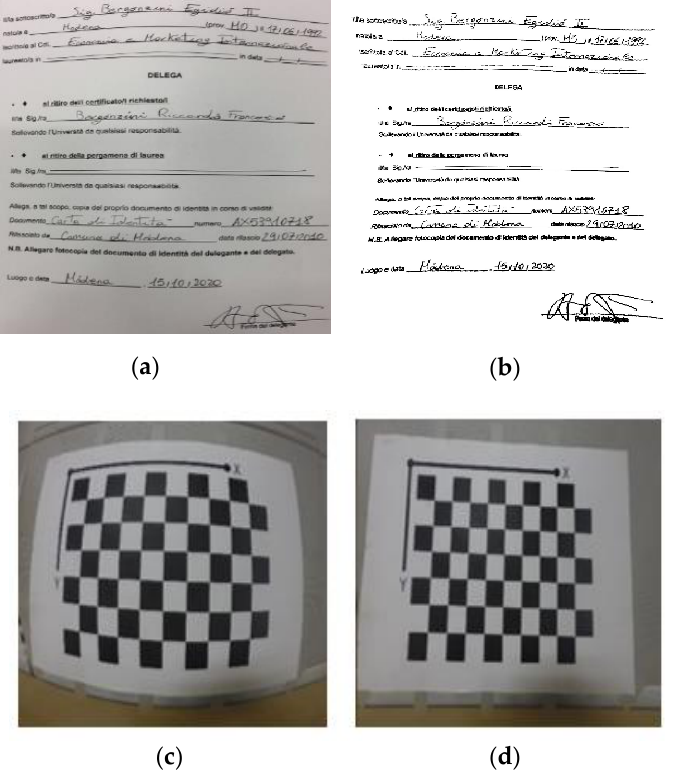
Figure 10. De-warping of the image. ( a ) original image. ( b ) de-warped image. ( c ) corresponding checkerboard of the warped document. ( d ) de-warped checkerboard.